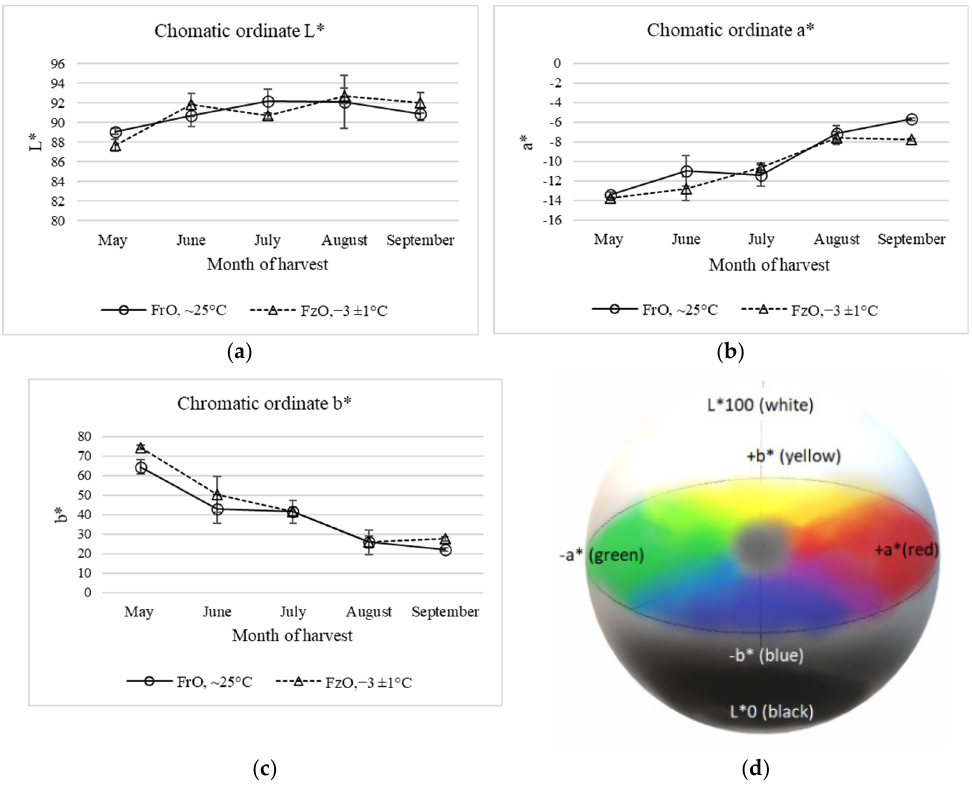
Figure 2. Color expressed as chromatic ordinates ( a ) L*, ( b ) a* and ( c ) b*, in VOO from fresh and frozen olives harvested between May and September. ( d ) Three-dimensional colour space CIELab.